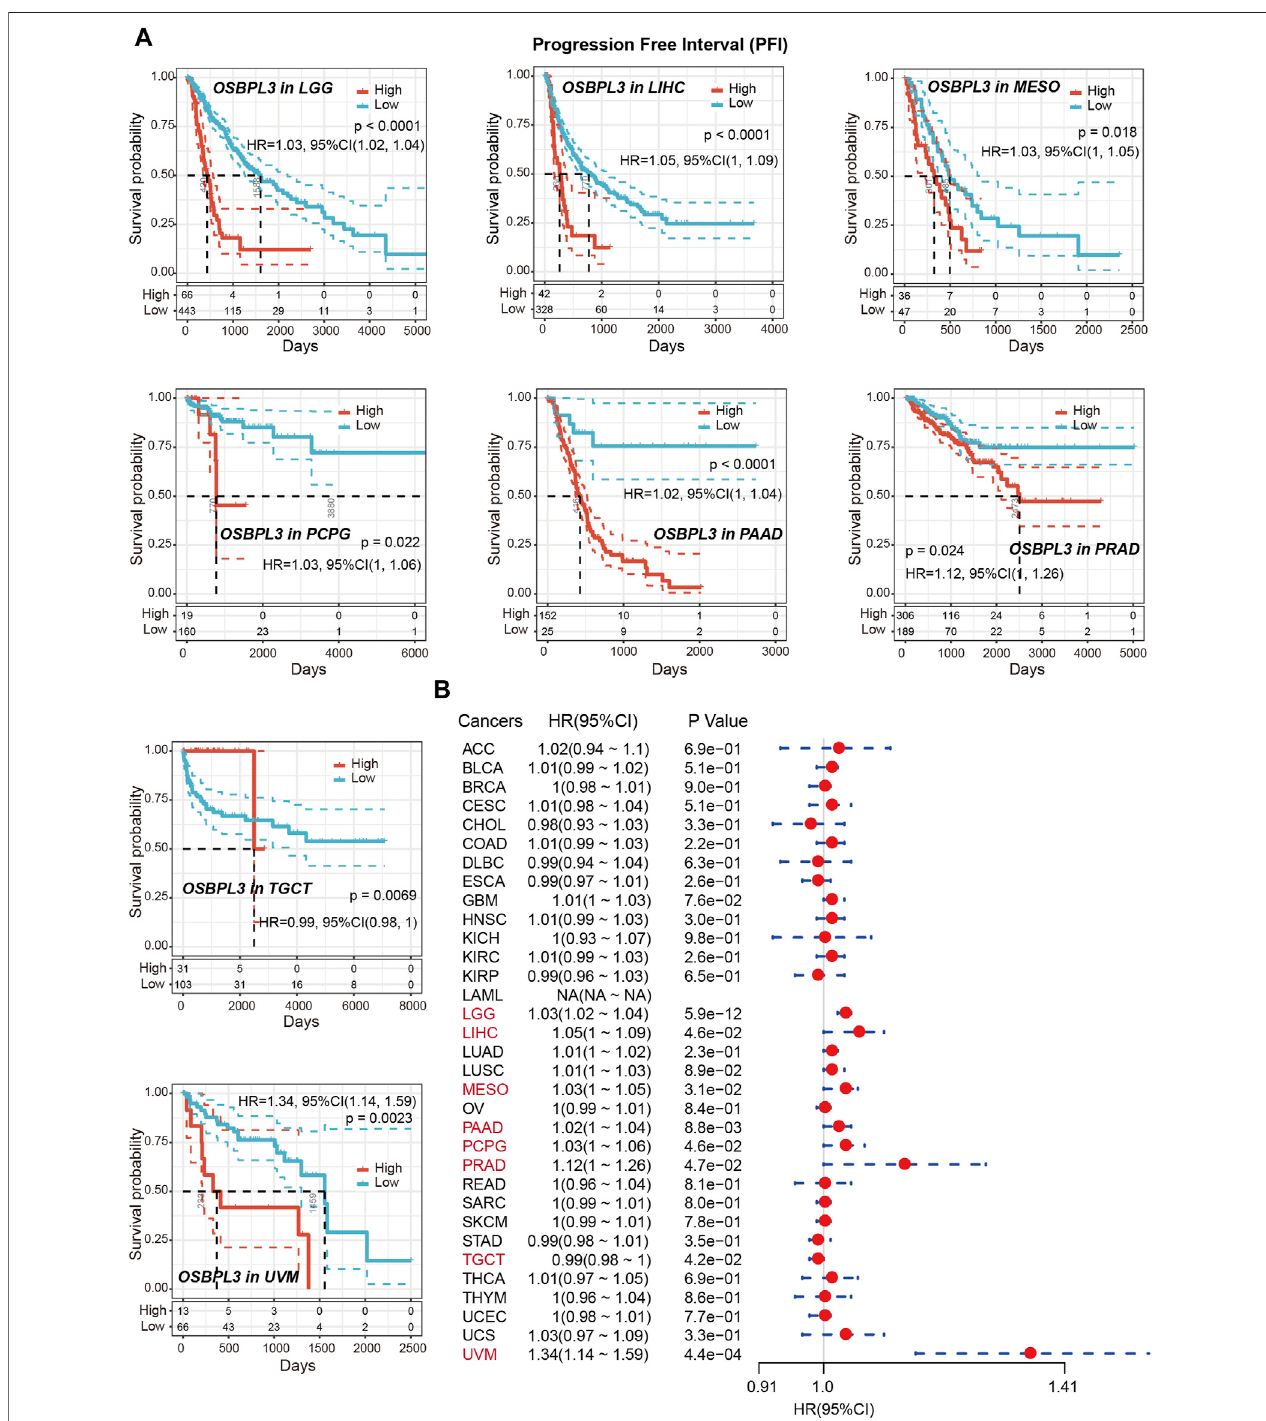
FIGURE 5 | Correlation between OSBPL3 expression and progression-free survival (PFS) prognosis of cancers in TCGA. (A ) Progression-free survival analyses of OSBPL3geneexpressionbyKaplan – MeiercurvesinLGG,LIHC,MESO,PCPG,PAAD,PRAD,TGCT,andUVMcancers. (B) Ameta-analysis(forestplot)forpoolingofa series of univariate progression-free survival analyses of OSBPL3 expression in different tumors. Hazard ratios (HRs), 95% con fi dence intervals (95% CIs), and p -values are shown.